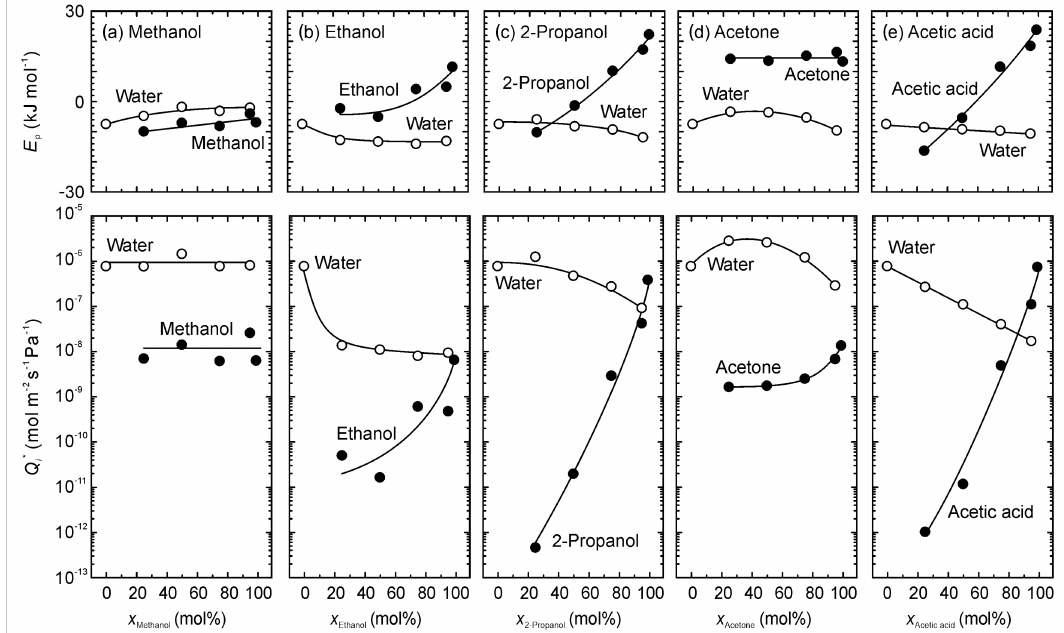
Figure 8. Pre-exponential factors and activation energies of water, methanol, ethanol, 2-propanol, acetone, and acetic acid as function of the organic solvent concentrations.